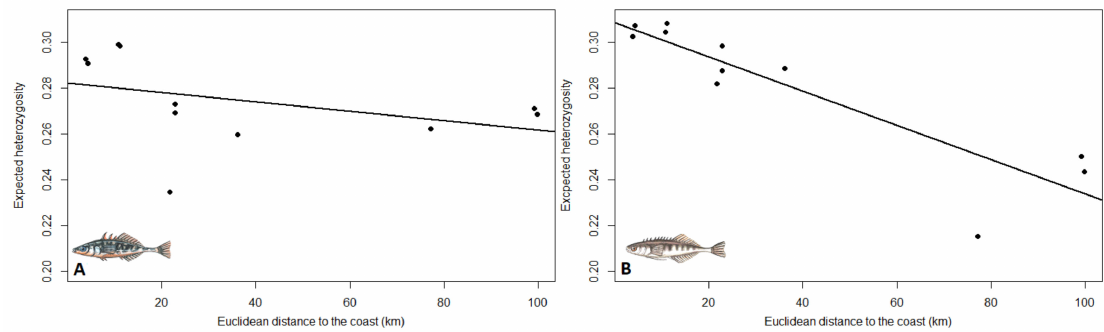
Figure 3. The relationship between Euclidean distance to the coast and expected heterozygosity in three-spined stickleback (A; slope = − 0.00020, P = 0.242) and nine-spined stickleback (B; slope = − 0.00075, P =